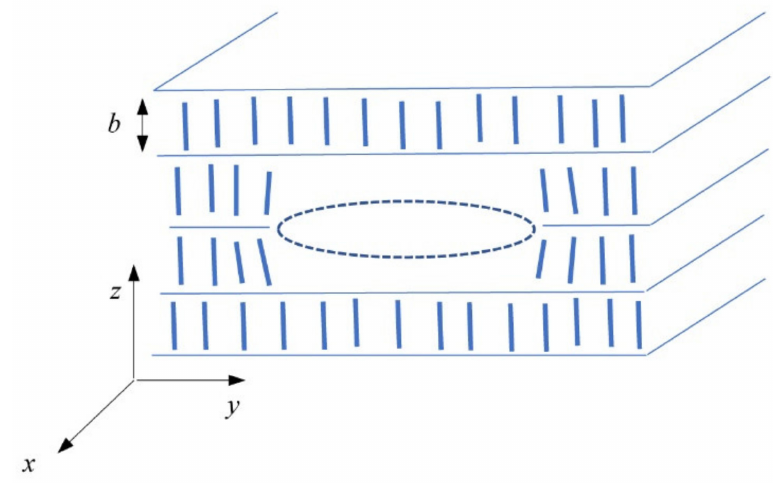
Figure 5. Schematic drawing of a prismatic dislocation loop with the Burgers vector 2 b in smectic layers. Rod-like molecules in layers are presented as small rods. A vacant volume is designed in the center of the loop where nanoparticles can condense. Orientation of the applied coordinate system is depicted; note that the z -axis is oriented along the layer